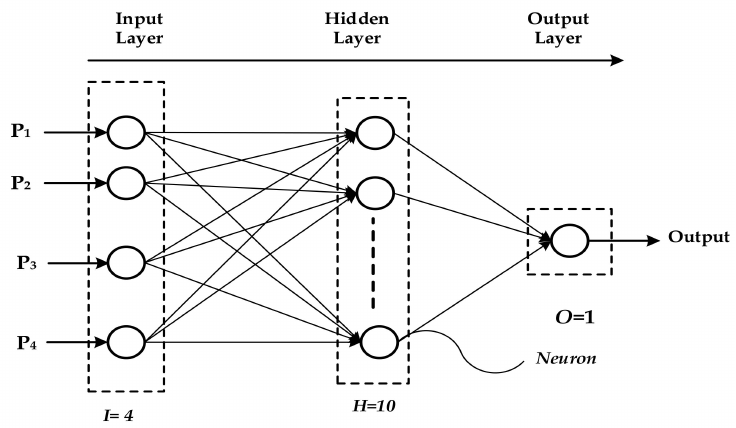
Figure 4. Structure of model M1 for four